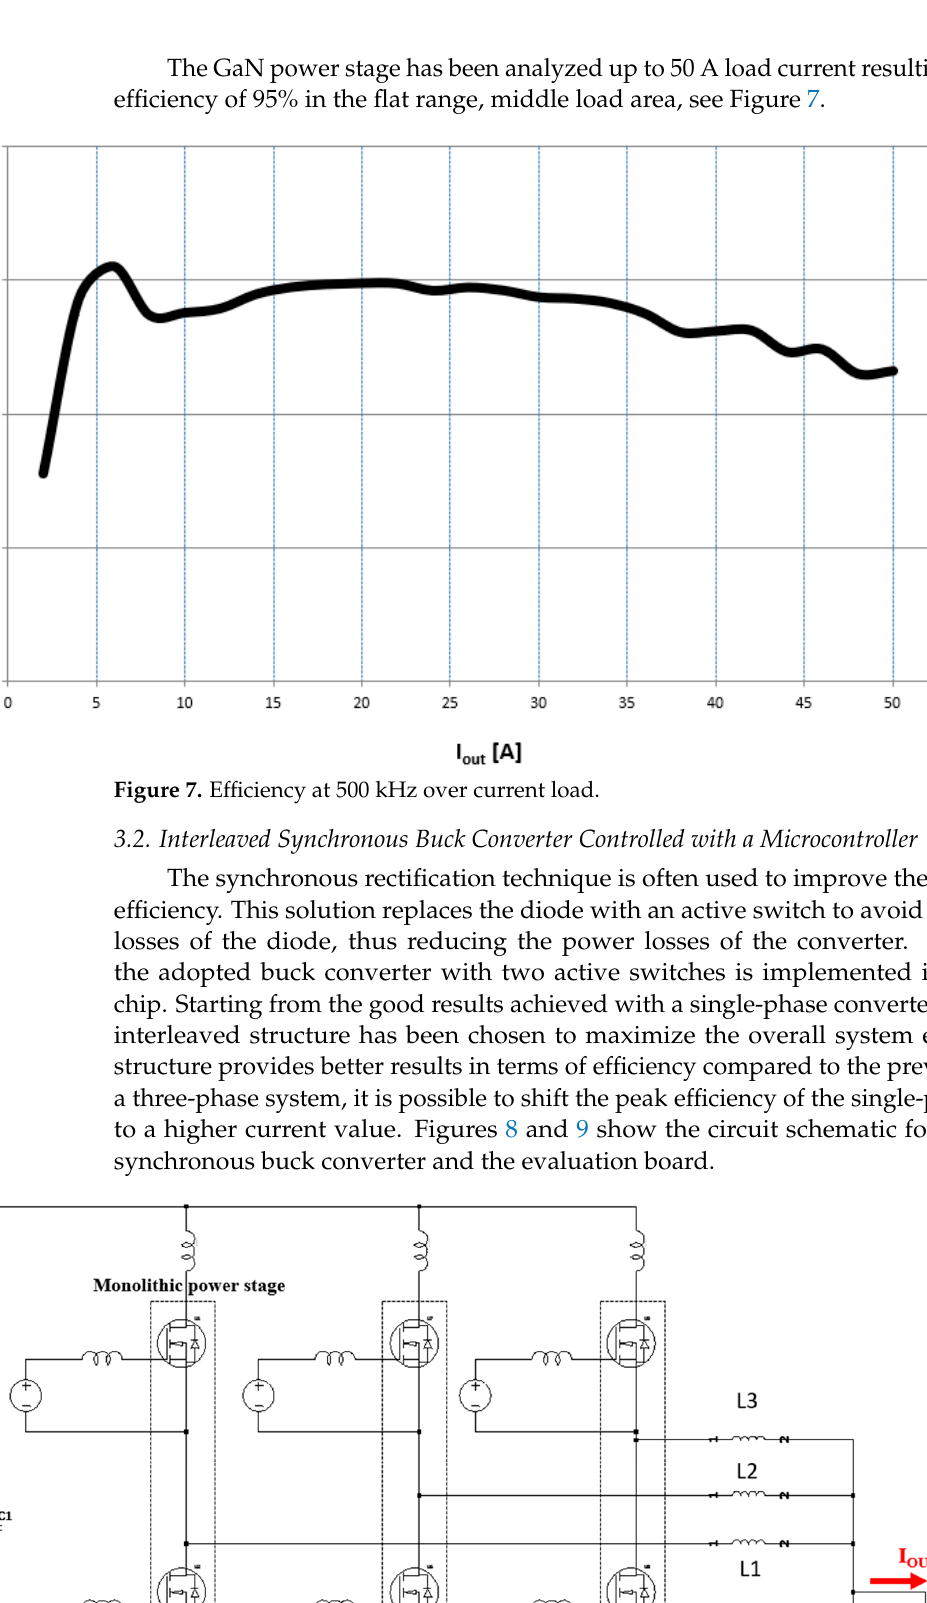
Figure 9. Evaluation board of the converter. The PWM signals and their phase shift are managed by the microcontroller STM32 Nucleo—F401RE. The complete system works at a 500 kHz switching frequency. The mi- crocontroller also implements the closed-loop control of the converter. For duty cycle reg- ulation the output voltage of the converter must be measured for modulation of the on- time amplitude of the three-phase PWM signals. The acquisition of the output voltage is performed by using a voltage divider with a 1:3 ratio and the information is provided to an ADC channel of the microcontroller. The over-current protection feature is useful to maximize system security. This function allows stopping the system when a peak of cur- rent occurs due to a short circuit or a failure of some devices. In the proposed converter, a shunt resistor sensor circuit is used for over-current valuation. In Figure 10 the main blocks are reported. A test bench has been equipped with a 64 Xi 600 MHz Le Croy Oscilloscope and PP- 005 Le Croy 500 MHz passive probes to view the drain-source voltage and current wave- forms. The Agilent 6012B DC Power Supply has been exploited to supply the gate driver’s